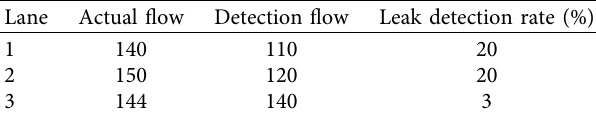
Table 4: Using pure video detection mode at 12 noon.